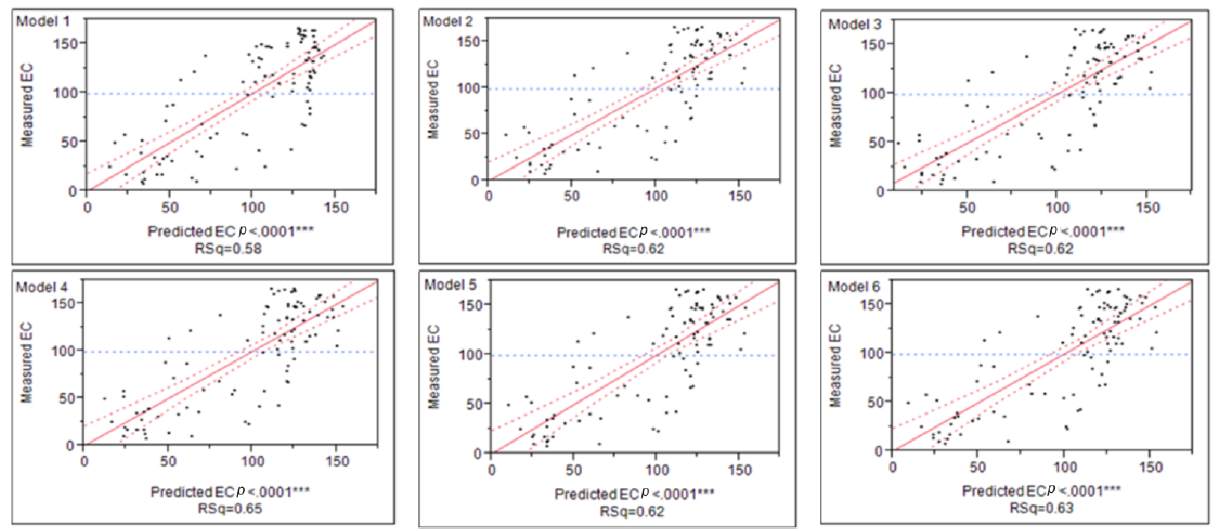
Figure 2. Scatter plots of predicted vs. measured EC using the developed regression models.